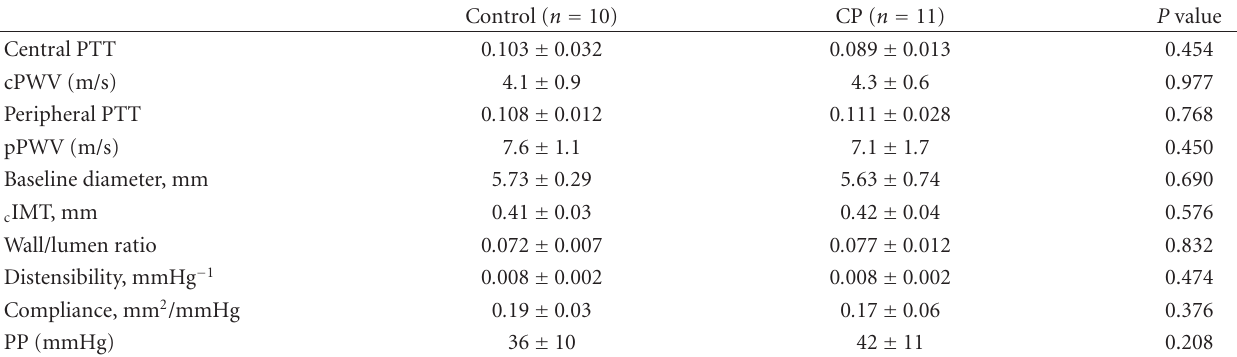
Table 3: Group comparisons of PTT, PWV, carotid vascular dimensions, and carotid distensibility.